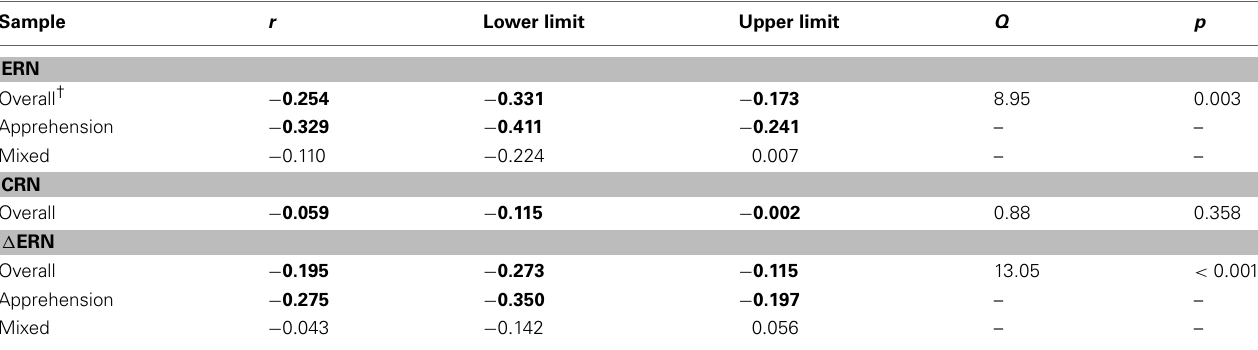
Table A1 | Results from the Meta-Analysis using the random effects